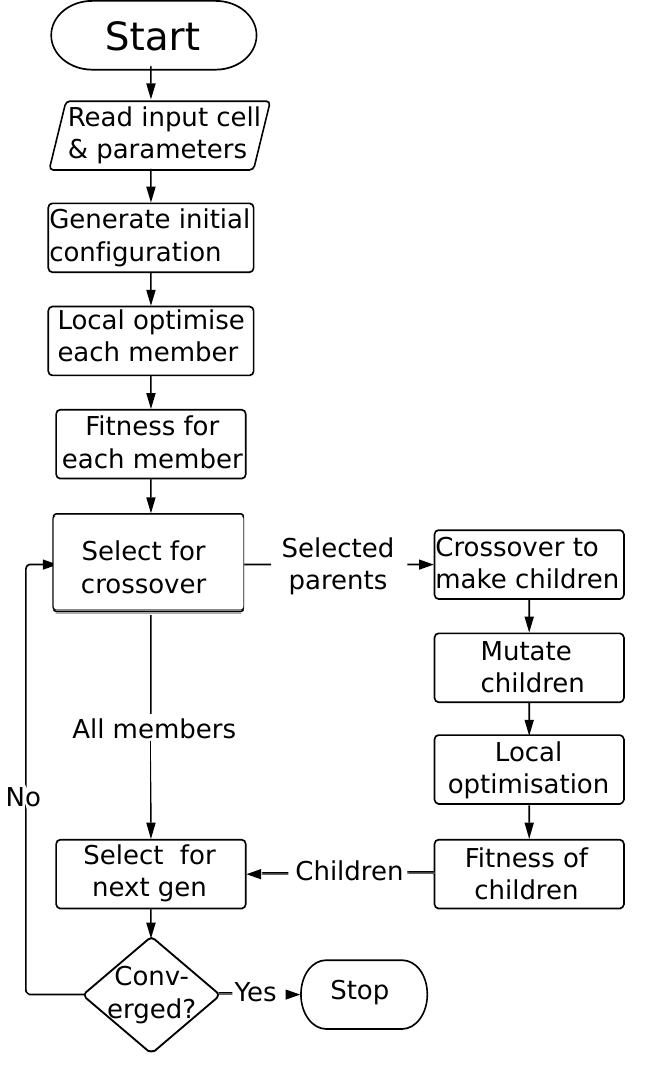
Figure 5. Schematic program flow of a genetic algorithm, as implemented in the CASTEP materials modelling